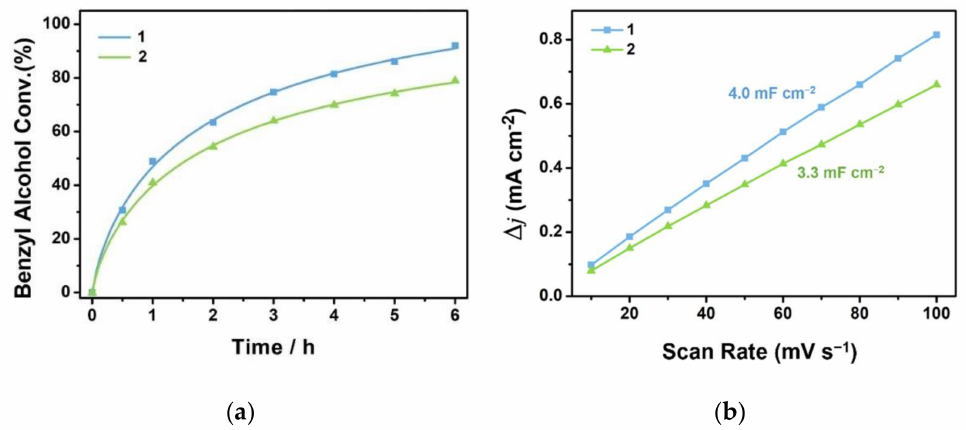
Figure 5. ( a ) Time profile for the electrocatalytic oxidation of BA by 1 and 2 ; ( b ) The scan-rate dependence of current density at potential = 0.07 V vs. Ag/Ag + for 1 and 2 . Table 1. Electrocatalytic selective oxidation of benzyl alcohol by different catalysts a .